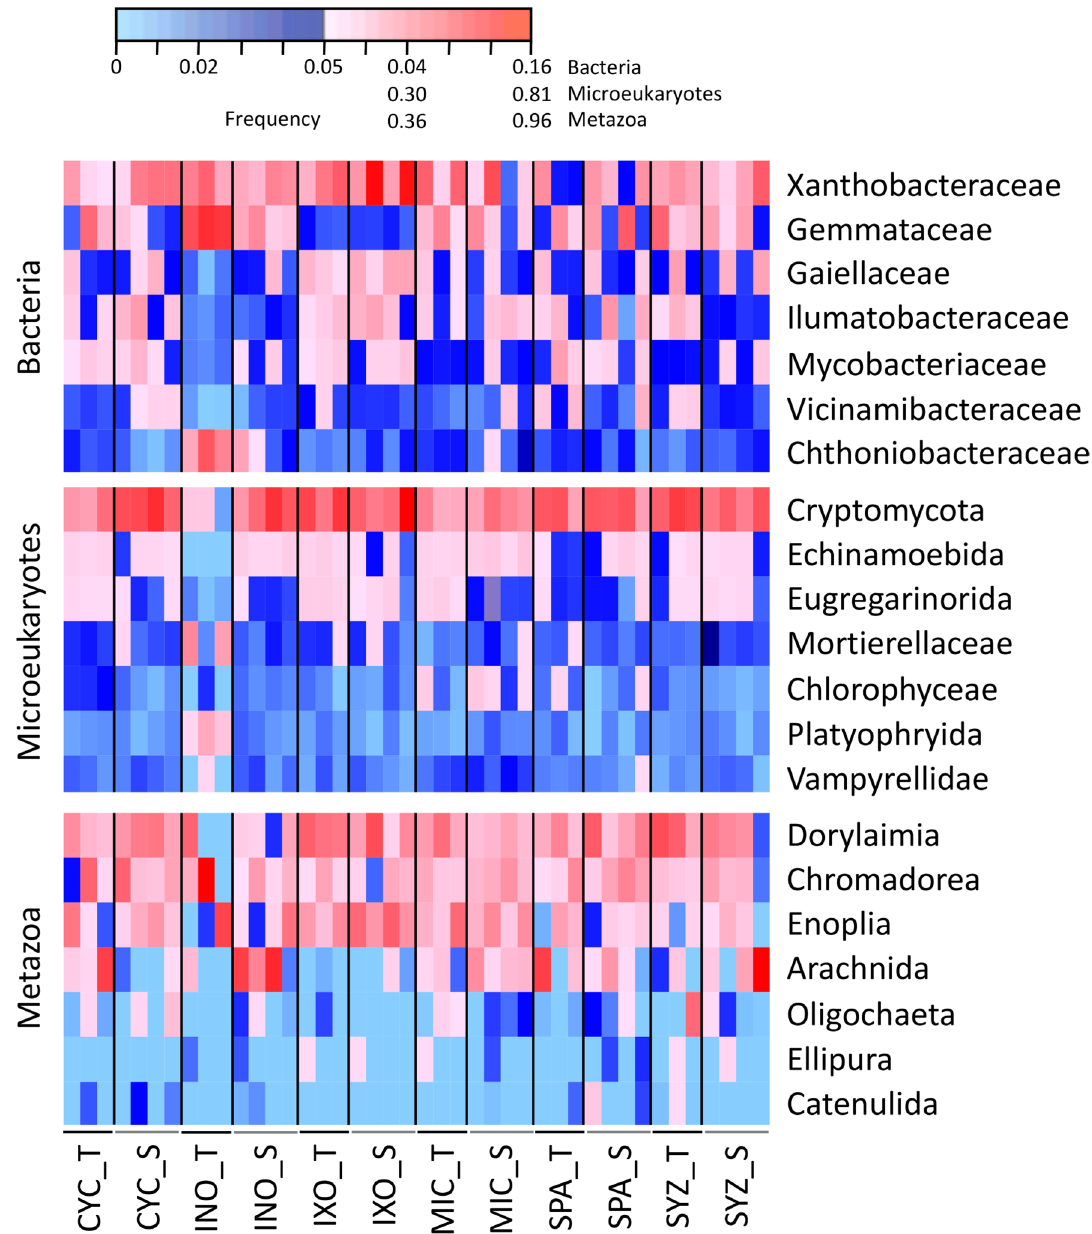
Figure 2. Dominant families at the sampling site for bacteria, microeukaryotes, and metazoans. CYC: Cyclophyllum barbatum , INO: Inocarpus fagifer , IXO: Ixora mooreensis , MIC: Miconia calvescens , SPA: Spathodea campanulata , SYZ: Syzygium malaccense . T: tree. S: seedling.